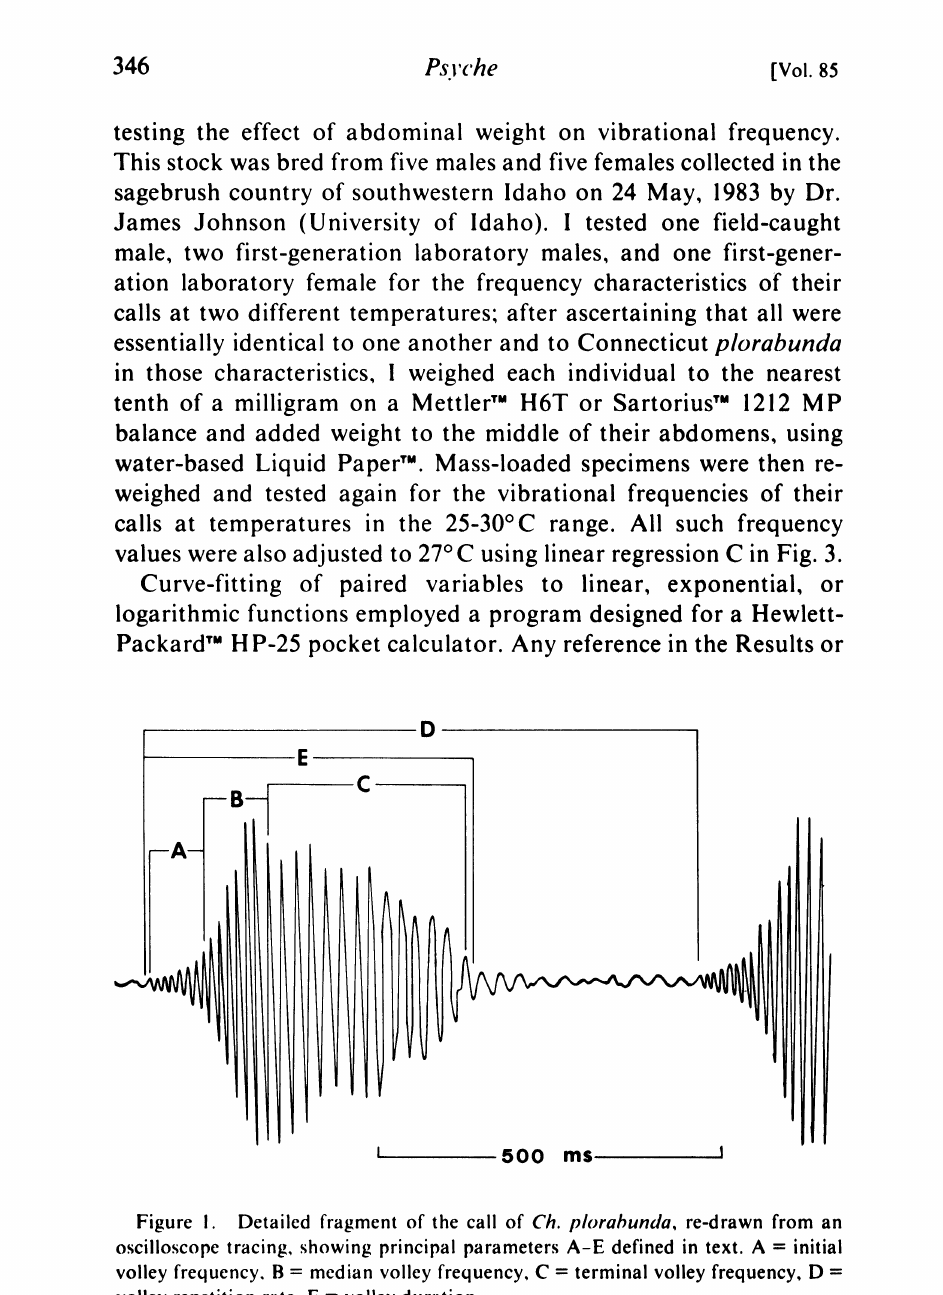
Figure I. Detailed fragment of the call of Ch. plorahunda, re-drawn from an oscilloscope tracing, showing principal parameters A-E defined in text. A initial volley frequency, B median volley frequency, C terminal volley frequency, D volley repetition rate, E volley